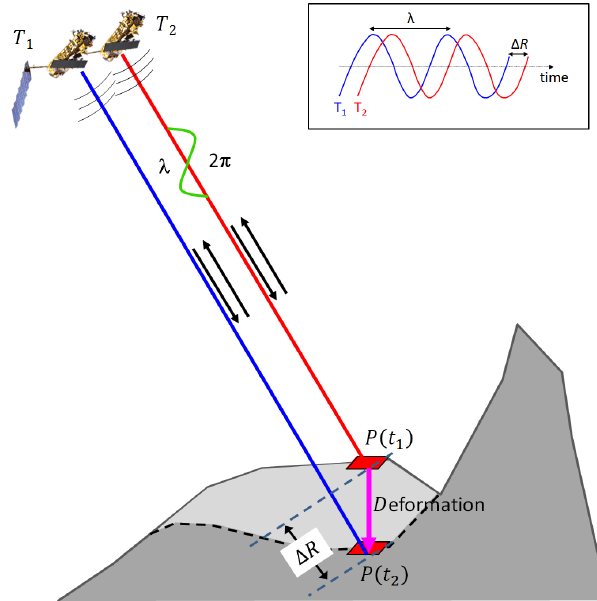
Fig. 4. DInSAR basic